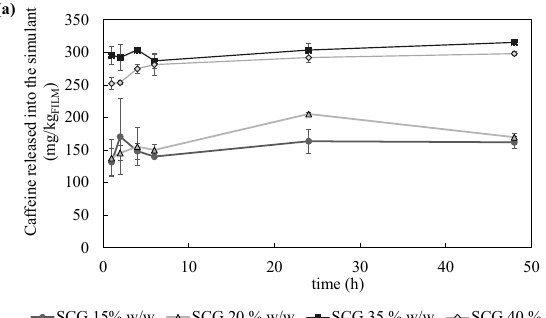
Figure 6. Results of the release tests on films obtained by spin coating in ethanol 10% (v/v), in terms of: ( a ) caffeine released per kg of film, ( b ) radical ABTS ● + inhibition. Different symbols indicate sta- tistically significant differences among values over time (p < 0.05) of dataset with the same extract loading.